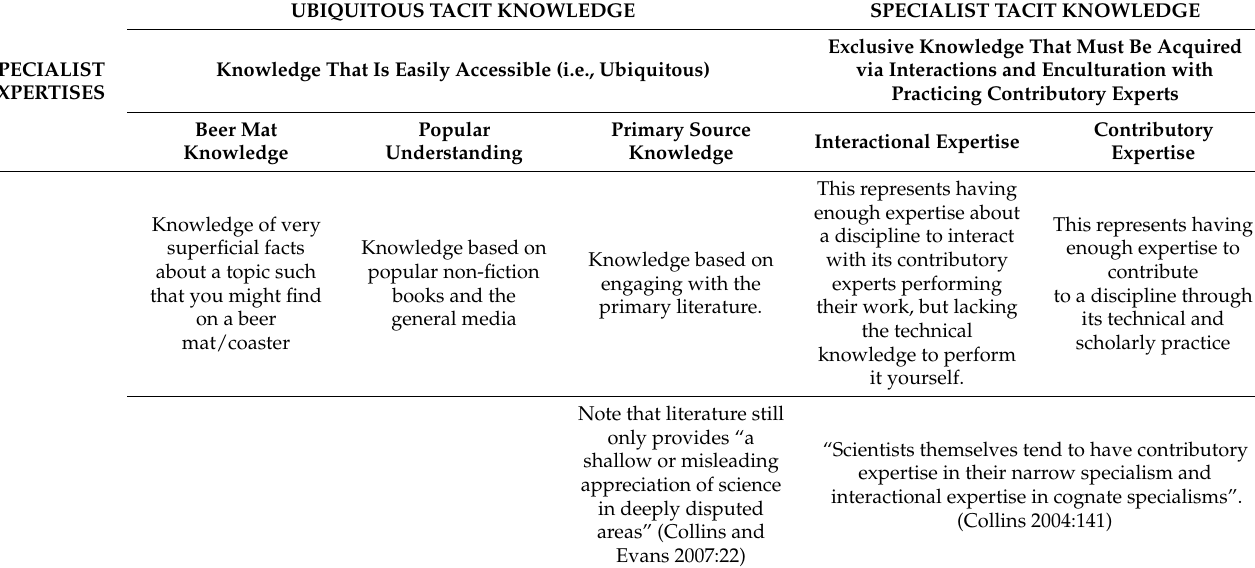
Table 1. Levels of expertise based on Collins and Evans